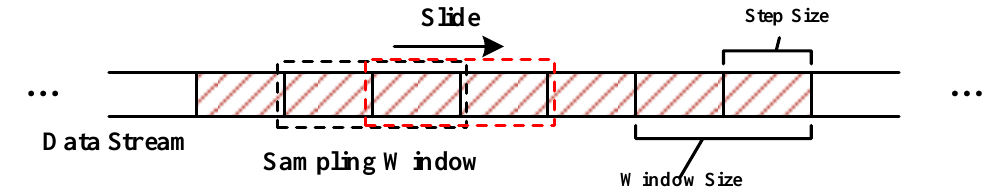
Figure 3. Sampling based on a sliding